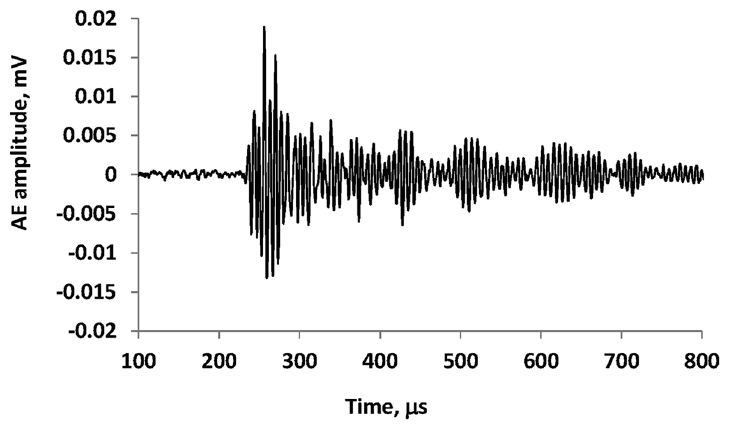
Figure 3. The example of AE